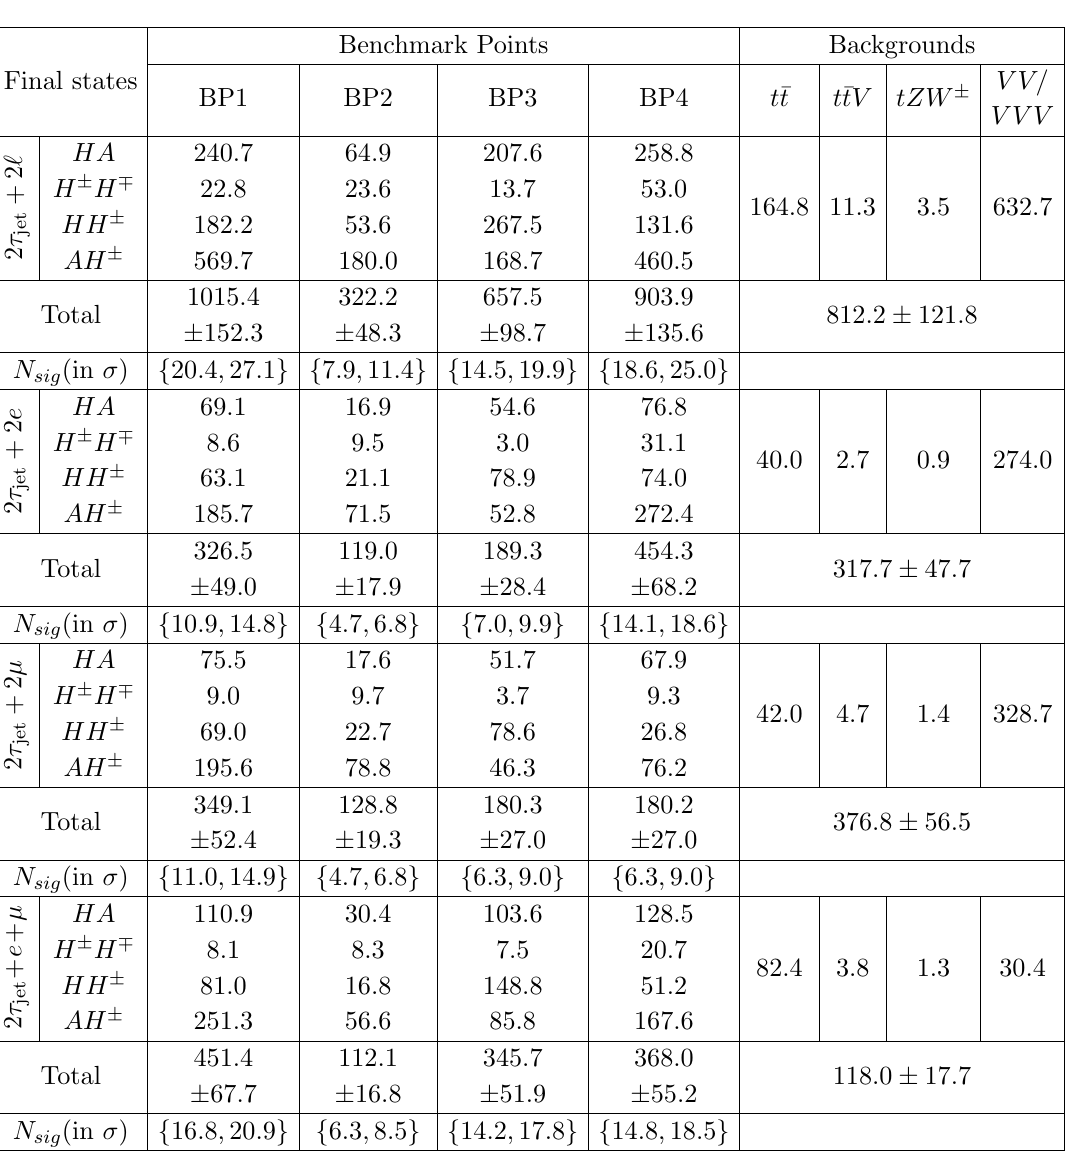
Table 7 . The number of events for 2 (cid:28) jet + 2 ‘ (cid:12)nal state at 100 fb (cid:0) 1 of integrated luminosity at the LHC with 14 TeV center of mass energy. The range for N sig is calculated incorporating the systematic uncertainties in signal and background events as well. The (cid:13)avour tagging ( e; (cid:22) ) has been